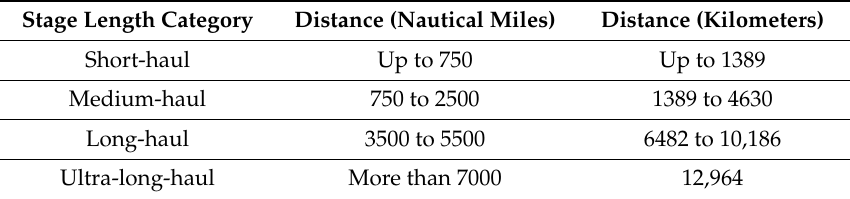
Table 2. The various flight stage categories in the global airline industry. Source: compiled from